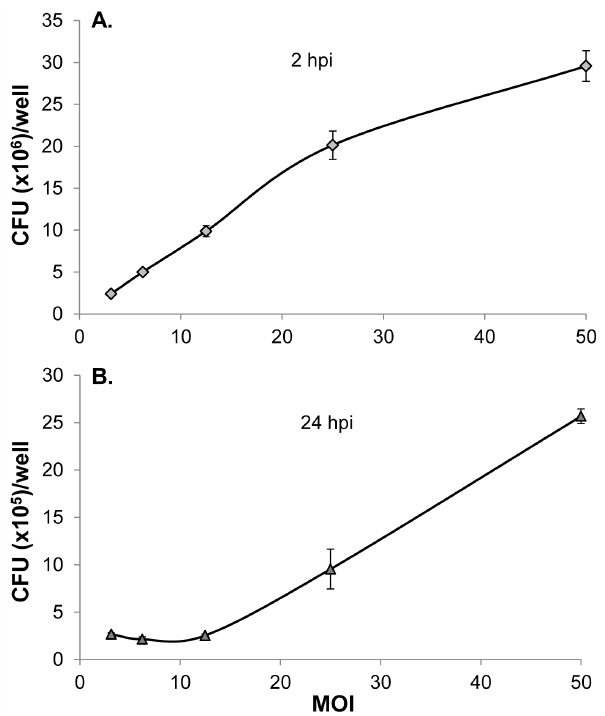
Figure 1. Intracellular S . Enteritidis in HD11 cells infected with various multiplicity of infection (MOI). HD11 cells were infected with S . Enteritidis at various MOI for 1 h in 24-well plates at 39 u C in a 5% CO2 humidified incubator. At 1 hour post infection (hpi), extracellular S . Enteritidis were killed by incubation with media containing 100 m g/mL of gentamicin sulfate for 1 h. Intracellular S . Enteritidis (cfu) were determined at 2 and 24 hpi. A. Intracellular S . Enteritidis (cfu) at 2 hpi; B. Intracellular S . Enteritidis (cfu) at 24 hpi.